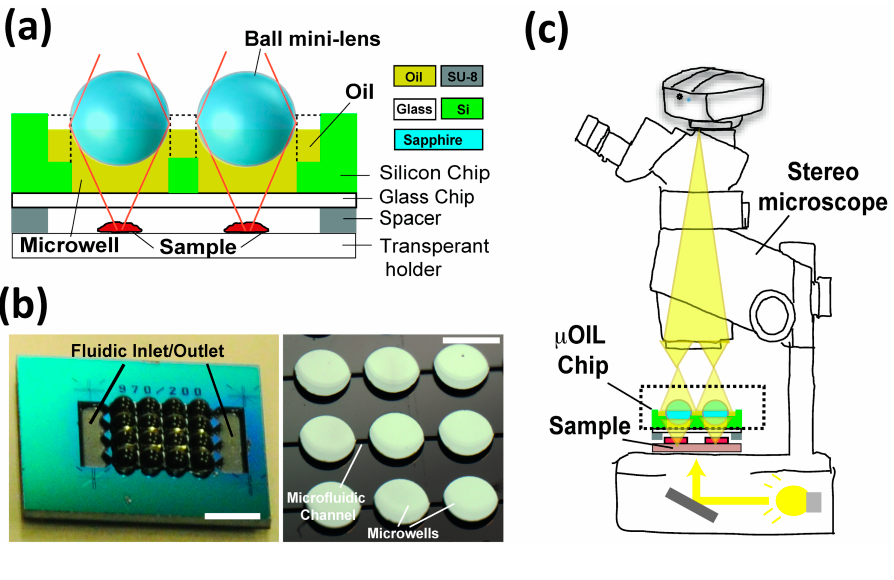
Figure 1. ( a ) Cross section schematic of the µOIL chip; ( b ) A picture ( left ) of the microfabricated µOIL chip (scale bar: 3 mm) and a close up view ( right ) of the microwell array with no ball mini-lenses (scale bar, 1 mm); and ( c ) The combined µOIL chip/stereo microscope system. The µOIL chip is placed directly on top of the sample of